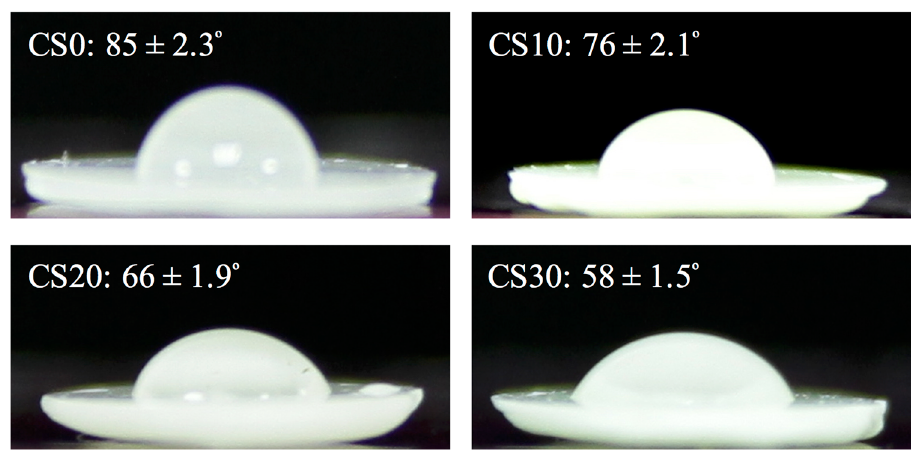
Figure 2. Water contact angle of different scaffolds.